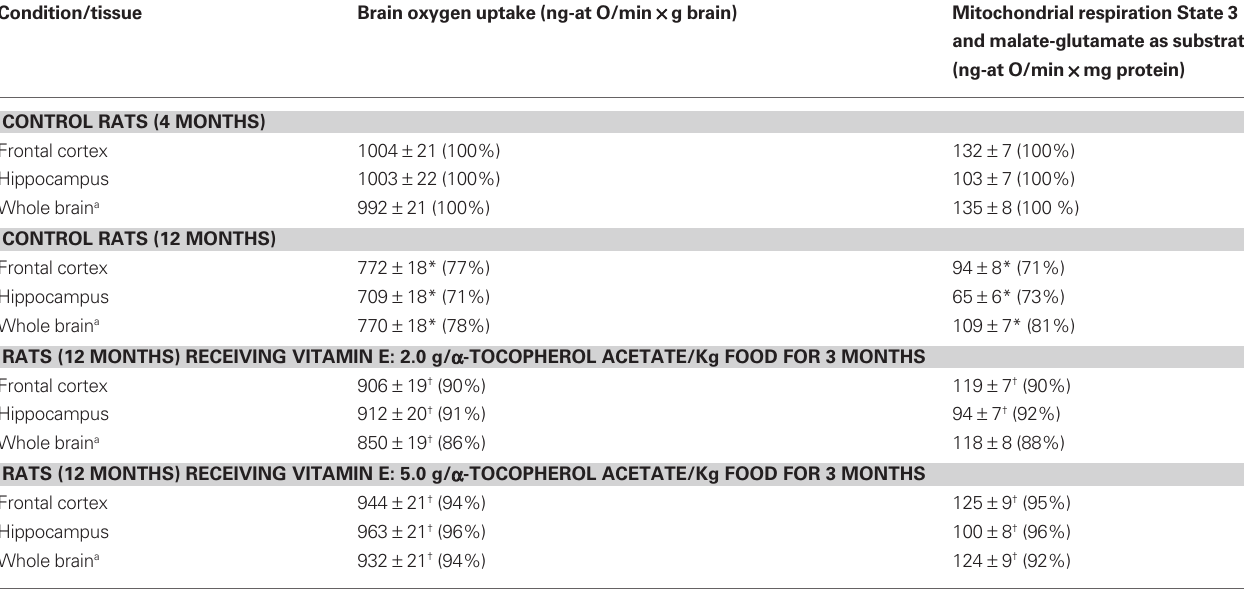
Table 2 | Effect of high doses of dietary vitamin E in tissue and mitochondrial respiration in frontal cortex, hippocampus, and whole brain of aging